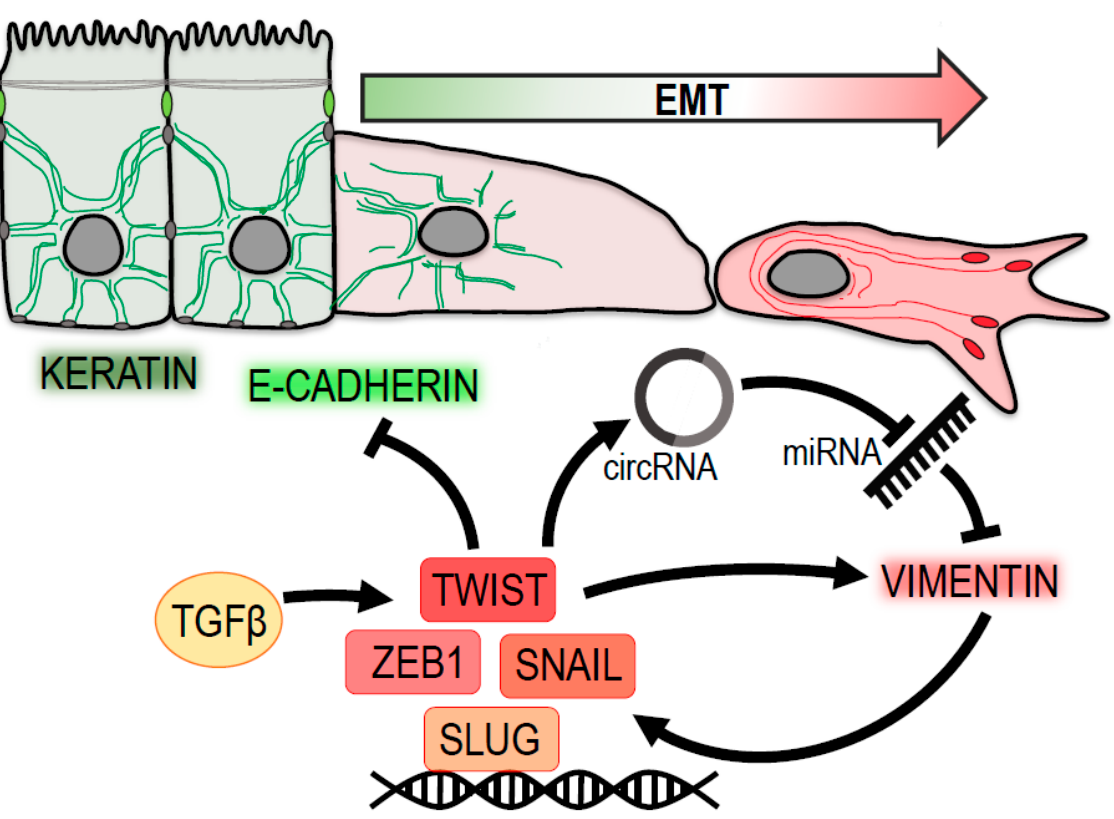
Figure 1. Vimentin at the center of epithelial-to-mesenchymal transition (EMT). Vimentin levels are positively associated with a loss of epithelial traits (green) and a gain of a pro-migratory mesenchymal phenotype (red). Vimentin expression is regulated by transcription factors Twist, Snail, Zeb1 and Slug, which are induced by TGF- β signaling. Twist suppresses the expression of epithelial keratins and E-cadherin. Moreover, it contributes to vimentin upregulation by promoting the expression of circular RNA circ-10720, which suppresses miRNA-mediated downregulation of vimentin. Vimentin itself enhances the expression of pro-mesenchymal transcription factors Snail and Slug.